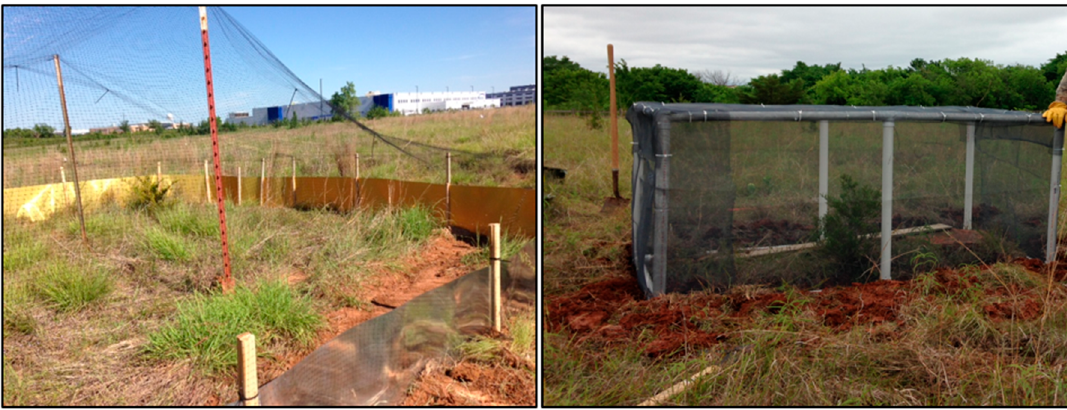
Figure 2. Soft-release pens built on Tinker Air Force Base, Oklahoma in 2016 to soft-release translocated Texas horned lizards ( Phrynosoma cornutum ). The pen on the left was constructed of aluminum flashing and wildlife netting and was approximately 0.01 ha in size while the pen on the right was constructed of PVC piping and fiberglass screen and measured 2 m long × 1 m wide × 1 m tall.